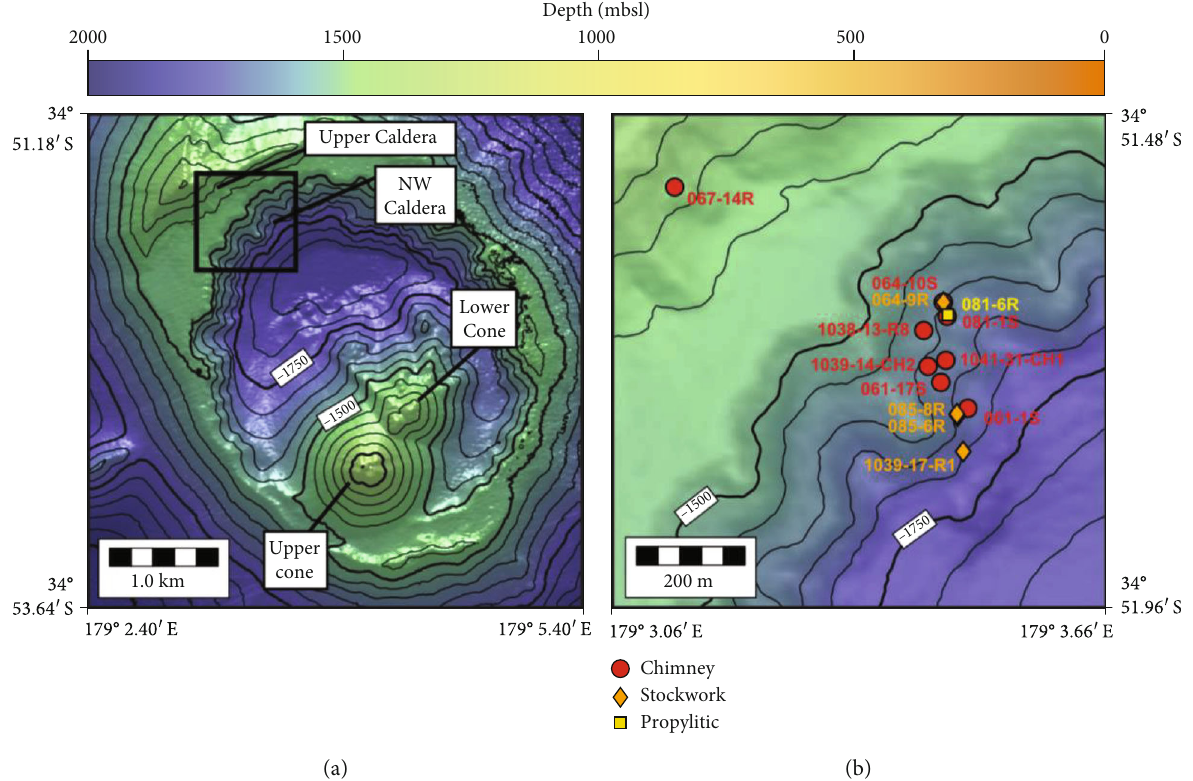
Figure 2: Bathymetry of Brothers caldera. (a) Overview and working areas of both cruises (SO253 and TN350). (b) Sample sites of hydrothermal chimneys, stockwork, and a propyliticly altered rock at the NW Caldera vent site (including one sample from the Upper Caldera). R/V Sonne multibeam data from cruise SO253